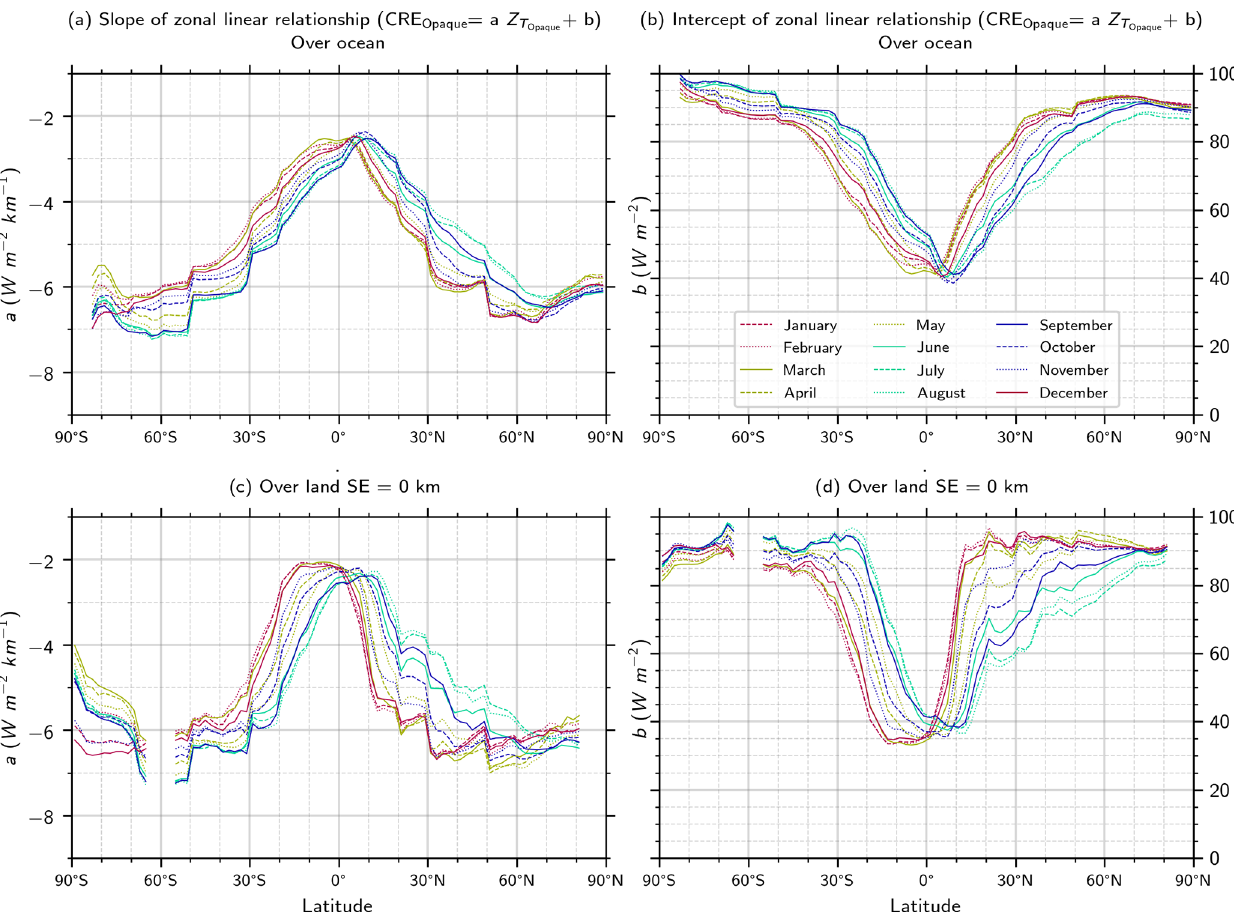
Figure 5. Coefficients of the linear relationships derived from 1D radiative transfer computations between the surface LW CRE and the cloud altitude for all latitudes and seasons: (a) the slope of the relationships over ocean, (b) the intercept of the relationships over ocean, (c) the slope of the relationships over land and (d) the intercept of the relationships over